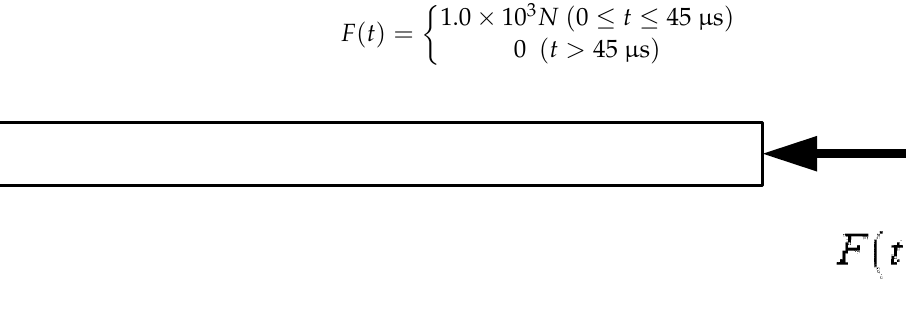
Figure 1. An elastic cement concrete column bearing an impulse load ( 90 × 1 element).